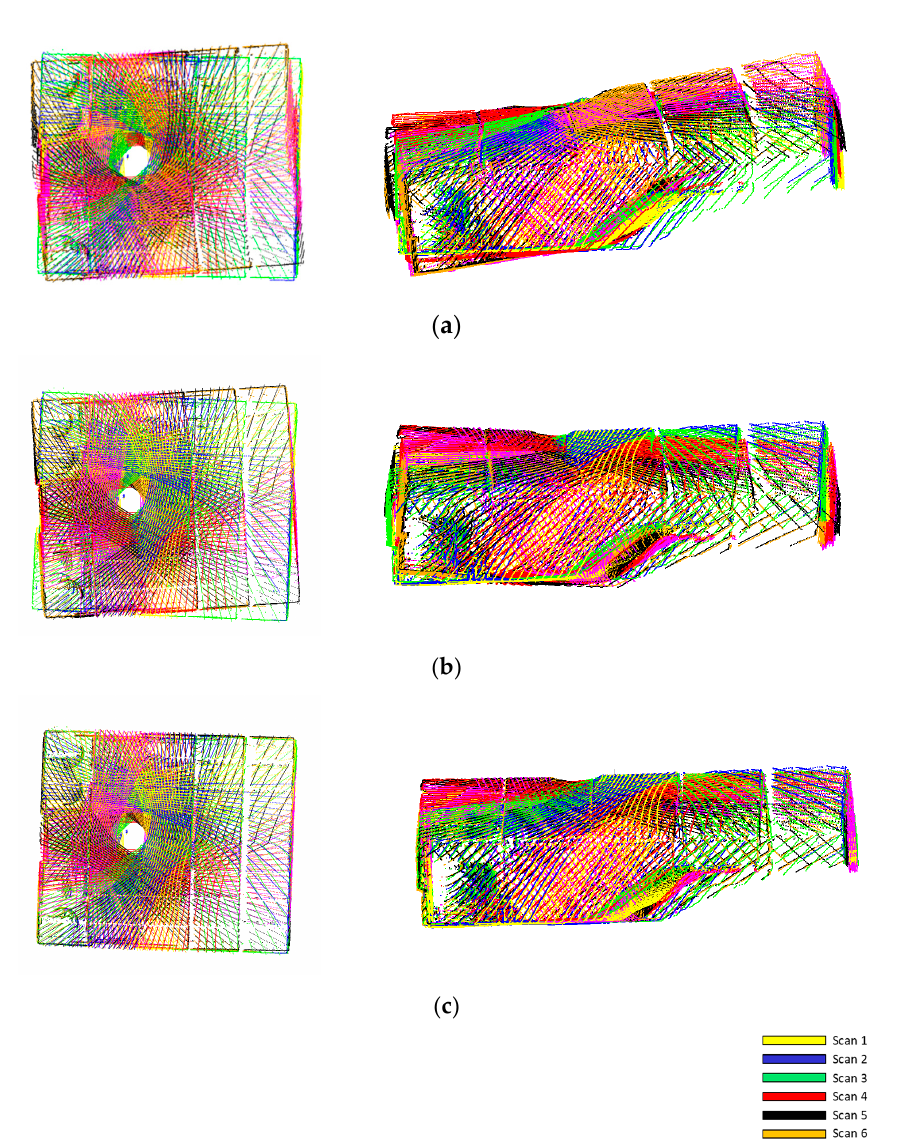
Figure 23. Top-view (left column) and side-view (right column) of coarse registration results for the SMART station in the US-231 dataset using parameters derived from: ( a ) exhaustive matching, ( b ) one-step constrained matching, and ( c ) iterative constrained matching. Point clouds are colored by their respective scan ID. Table 5. Accuracy assessment of post-fine registration of point clouds in the Lebanon and US-231 facilities.